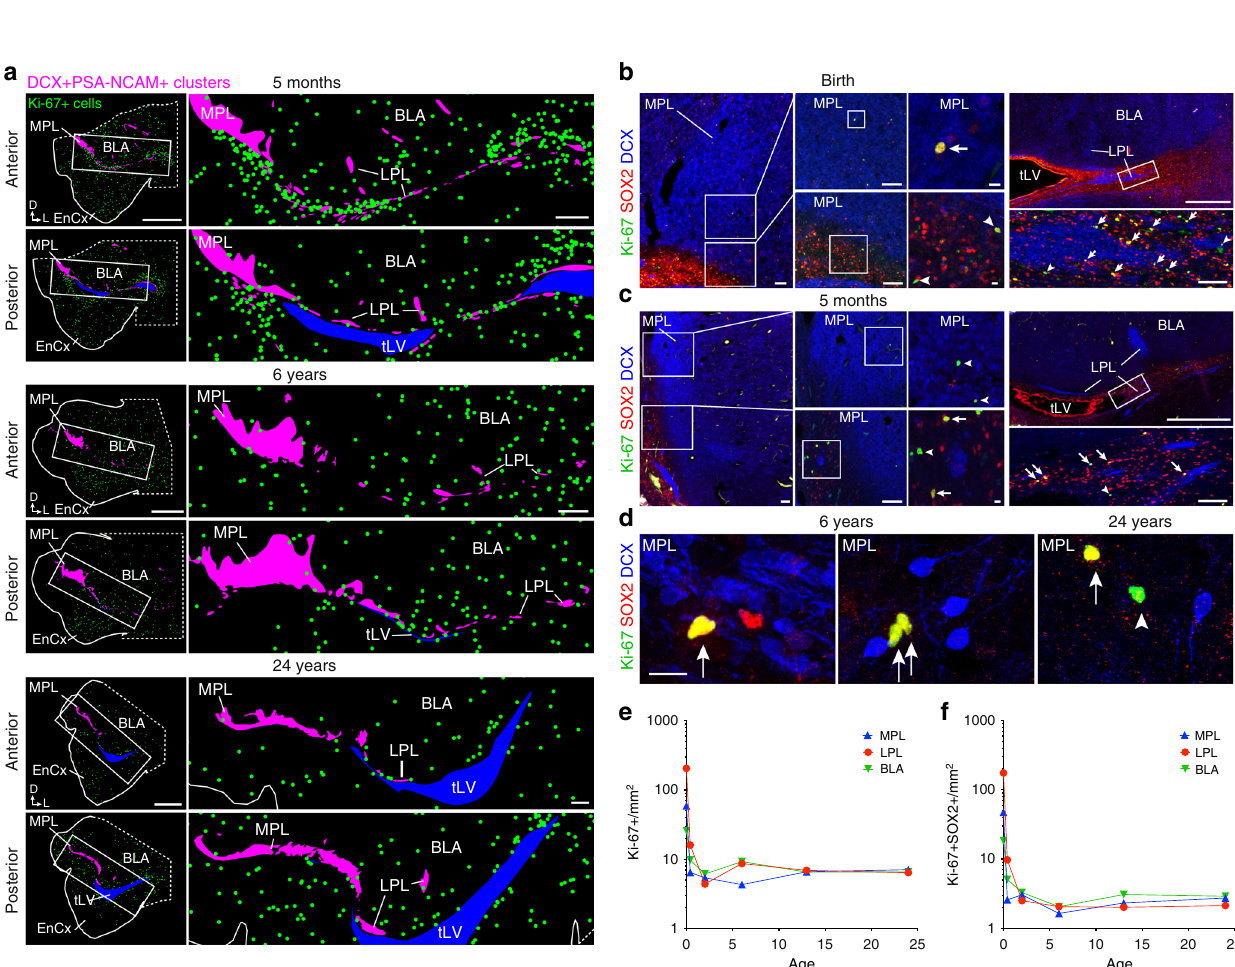
Fig. 5 CB + neurons increase in the PL throughout life. a DCX + (arrowheads) and CB + (arrows) cells in the MPL from birth to 67 years. (Inset) High magni fi cation. b DCX + (arrowheads) and CB + (arrows) cells in the LPL from birth to 77 years. (Right) High magni fi cation. c – e Quanti fi cation of cells in the LPL from birth to 77 years of age. Each data point corresponds to one individual; line indicates non-linear exponential fi t. c Density of DAPI + nuclei in the LPL from birth to 77 years . d CB + cell density in the LPL from birth to 77 years. e Percentage of CB + DAPI + cells in the LPL from birth to 77 years. f (Top) 77-year-old amygdala with two LPL cross-sections: one in the BLA containing few DCX + cells and many CB + cells and one in the white matter (wm) ventral to the BLA with many DCX + cells and few CB + cells. (Inset) higher magni fi cation of the LPL in the white matter. (Bottom) Higher magni fi cation of the LPL in the BLA and examples of small DCX + cells in this region. g CB + TBR1 + VGLUT2 + cells (arrows) in the (Left) MPL and (Right) LPL at 13 years. h DCX + and TBR1 + cells in the MPL and LPL at 13 years. (Inset) Double-positive DCX + TBR1 + cell in the MPL. i DCX + TBR1 + and TBR1 + NeuN + neurons in the MPL at 13 years. (Top inset) small DCX + TBR1 + cell (arrow) and small DCX + TBR1 – cell (arrowhead). (Middle inset) intermediate-sized DCX + TBR1 + cell (arrow) and DCX – TBR1 + NeuN + cell (arrowhead). (Bottom inset) Large DCX – TBR1 + NeuN + cells (arrowheads). j DCX + TBR1 + VGLUT2 – cells (arrows) and DCX – TBR1 + VGLUT2 + cells (arrowheads) in the MPL at 13 years. Scale bars: 100 µ m ( a , b left, f top, h ), 20 µ m ( a insets, b right, f top inset, f bottom left, g , i left, j ), 10 µ m ( h left inset, i right insets), 5 µ m ( f lower right insets)